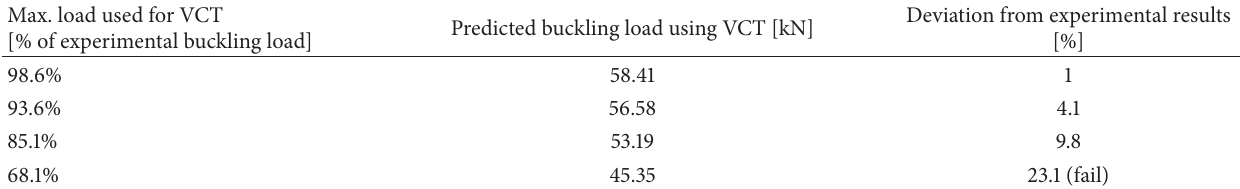
Table 9: Buckling load prediction using the VCT approach for different loading ranges on Z37 cylinder.